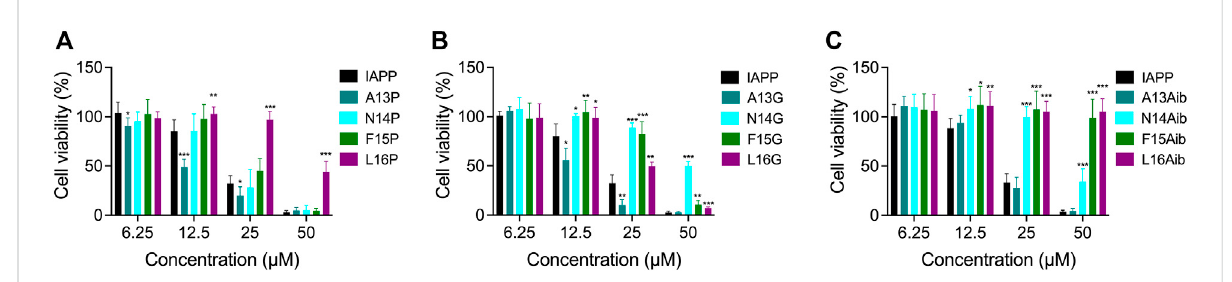
FIGURE 9 CytotoxicityofPro,GlyandAibsubstitutedIAPP. (A – C) INS-1Ecellswereincubatedwithincreasingconcentrationsoffreshlydissolvedpeptides for24 h.Cellviabilitywasmeasuredusingtheresazurinreductionassayandcomparedwithcellstreatedwithvehicle.Dataofatleast fi veassayswere averaged and expressed as the mean ± S.D. Results were analyzed using Student ’ s t test, and statistically signi fi cant difference between IAPP and analogs was established at: (*) p < 0.05; (**) p < 0.005; (***) p <